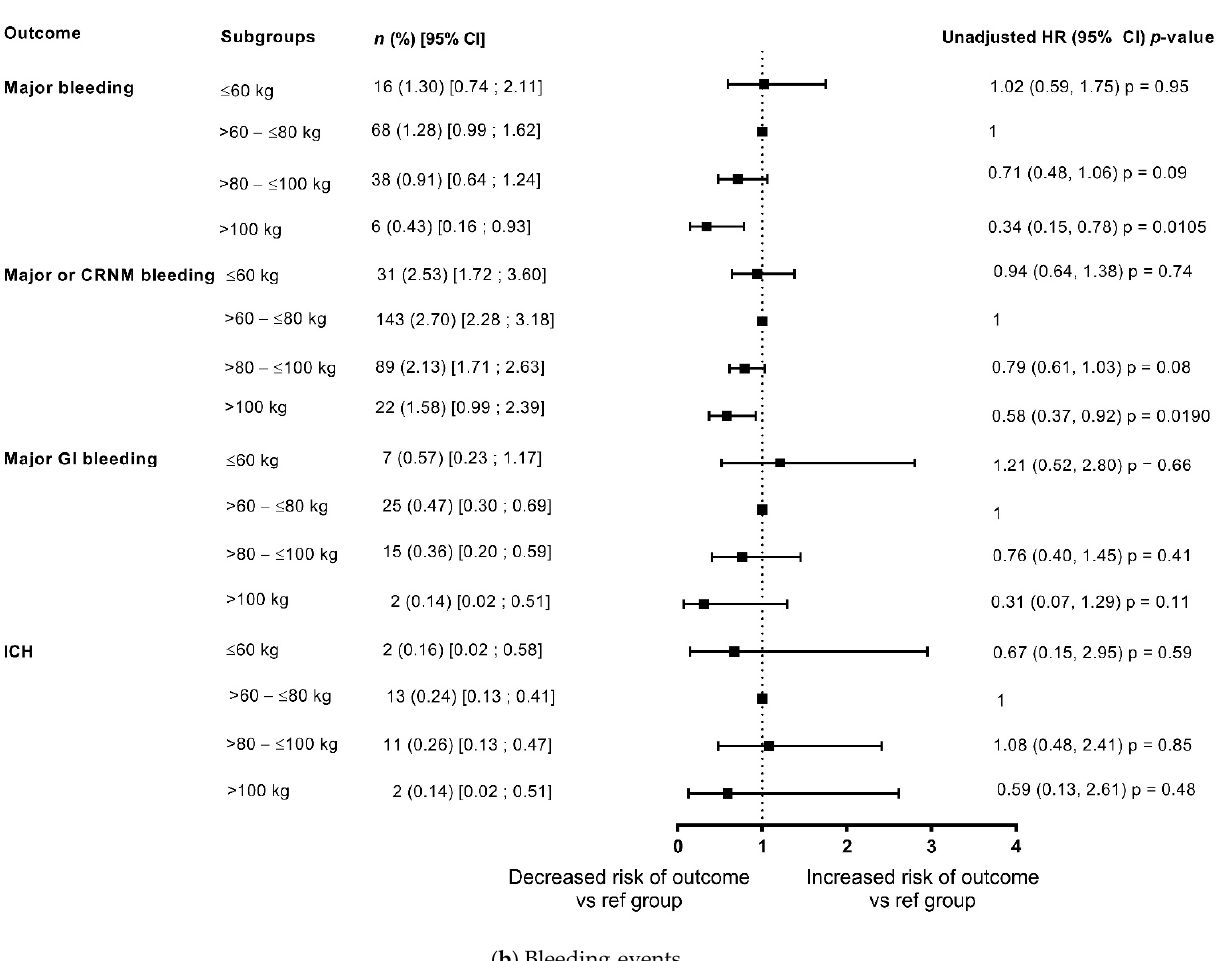
Figure 2. Outcomes at 1-year categorised by body weight (unadjusted data) compared with reference weight group (>60– ≤ 80 kg). ( a ) Events of stroke and mortality; ( b ) Bleeding events. CRNM, clinically relevant non-major bleeding; GI, gastrointestinal; ICH, intracranial haemorrhage.